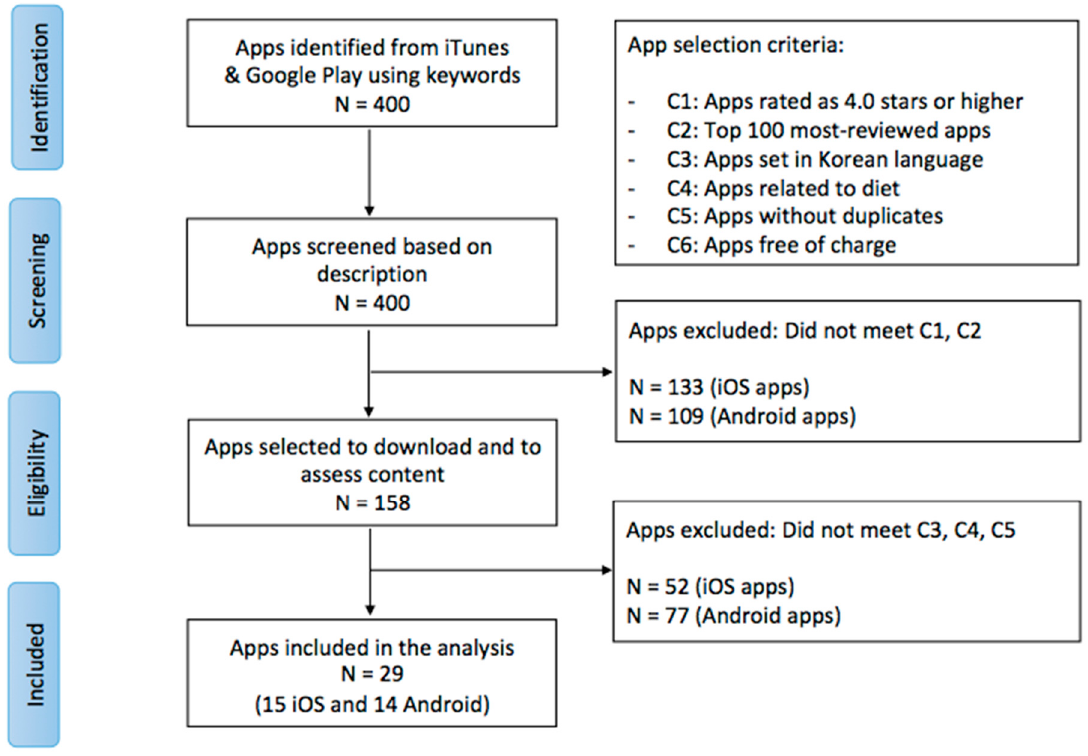
Figure 1. Flowchart of application (app) selection.